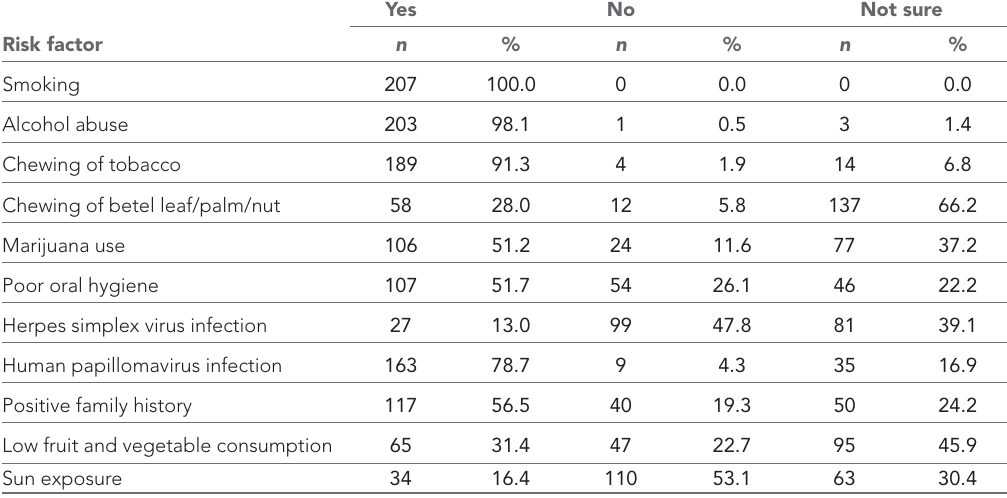
Table 3 Knowledge of reported risk factors for oropharyngeal cancer among 207 GPs in the